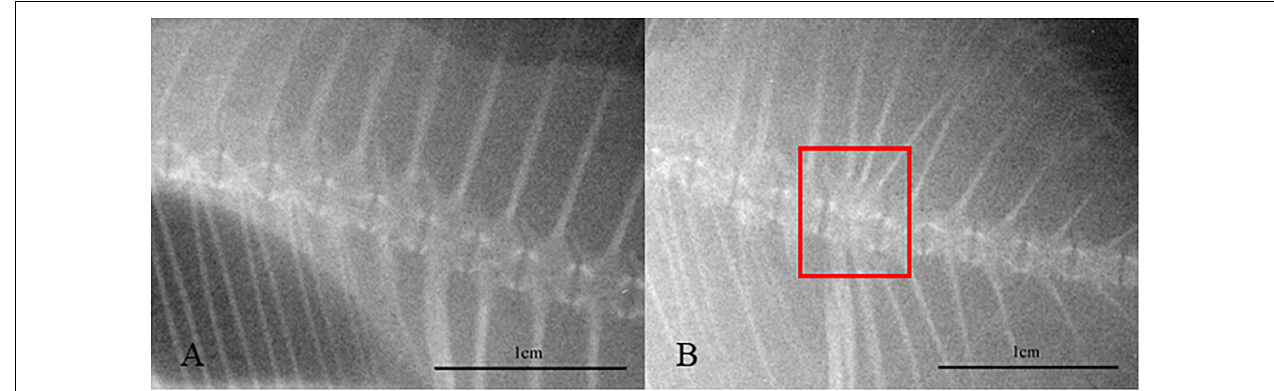
FIGURE 1 | Radiographic images of normal (A) and fused (B) vertebral bodies. The red square area represents the vertebrae where fusion occurred.